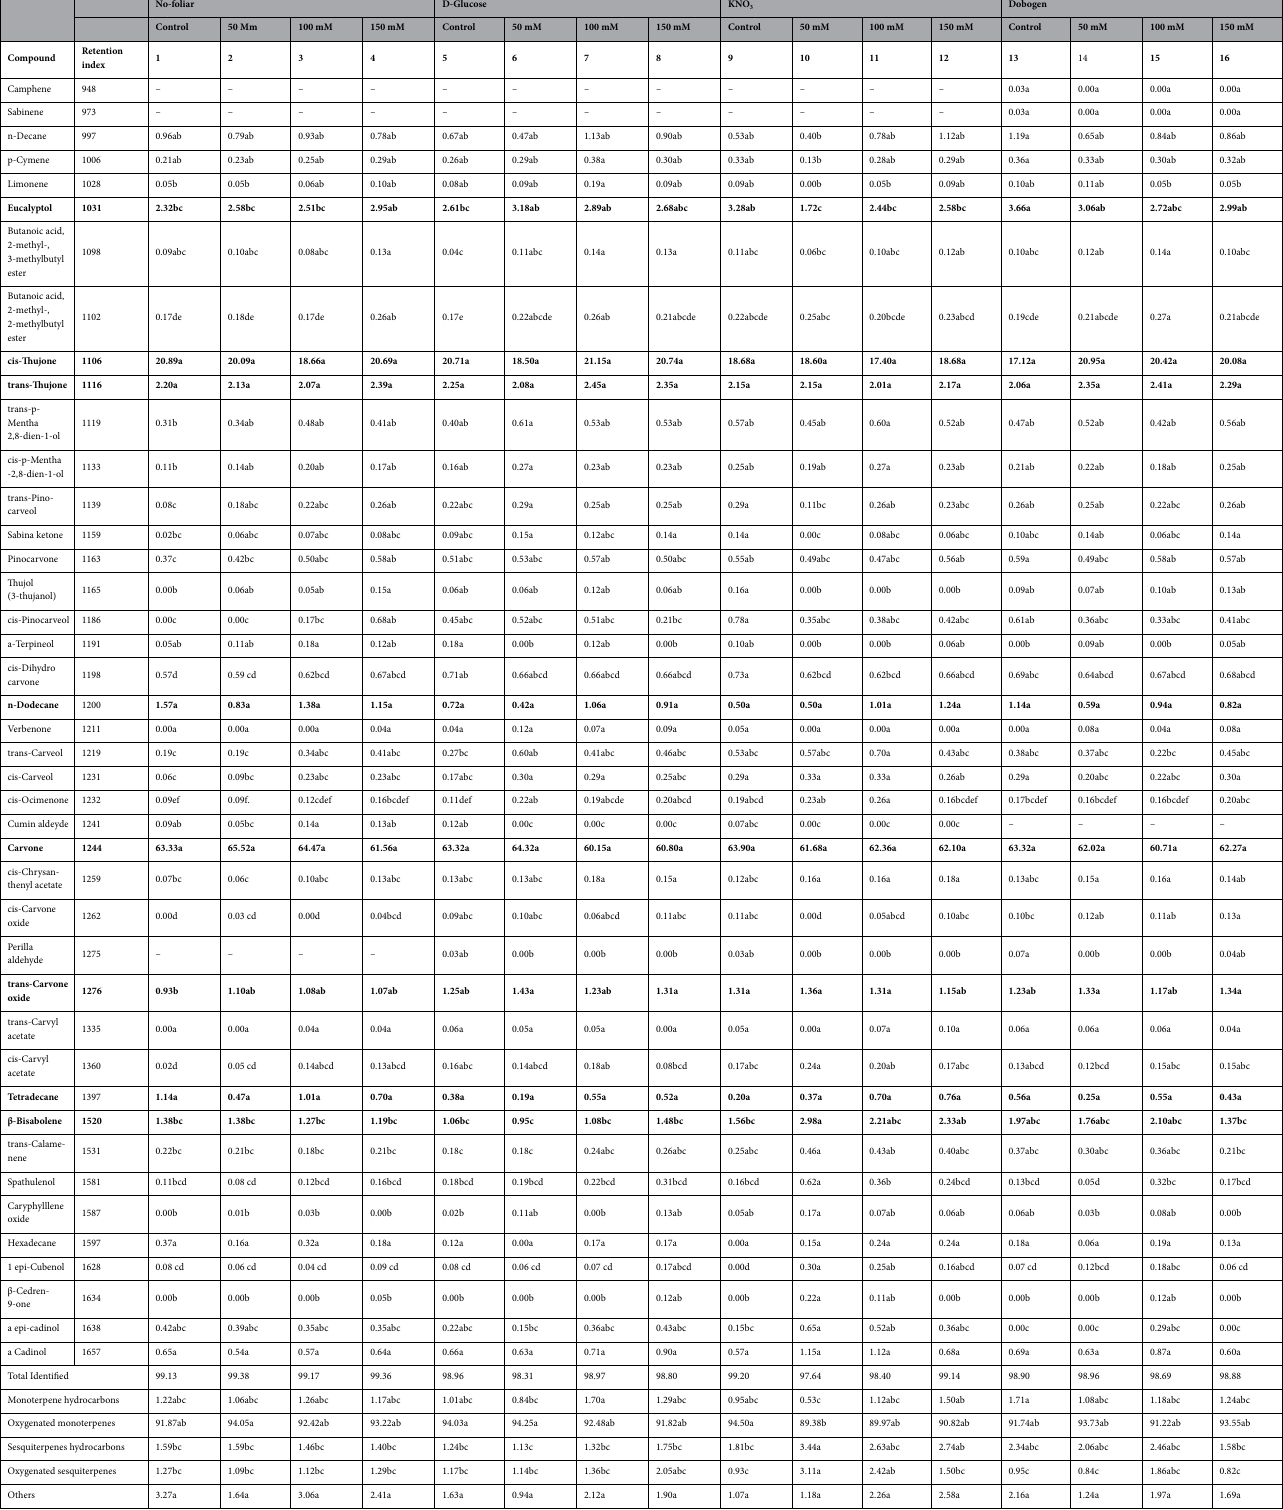
Table 9. Chemical composition (%) of essential oils of costmary plants exposed to salinity (0, 50, 100, and 150 mM NaCl) and foliar applications (no-foliar, 2 g L −1 glucose, 2 g L −1 KNO 3 , and 2% Dobogen). Values (n = 3) in rows for each treatment followed by the same letter are not significantly different, P ≤ 0.05. Significant values are in